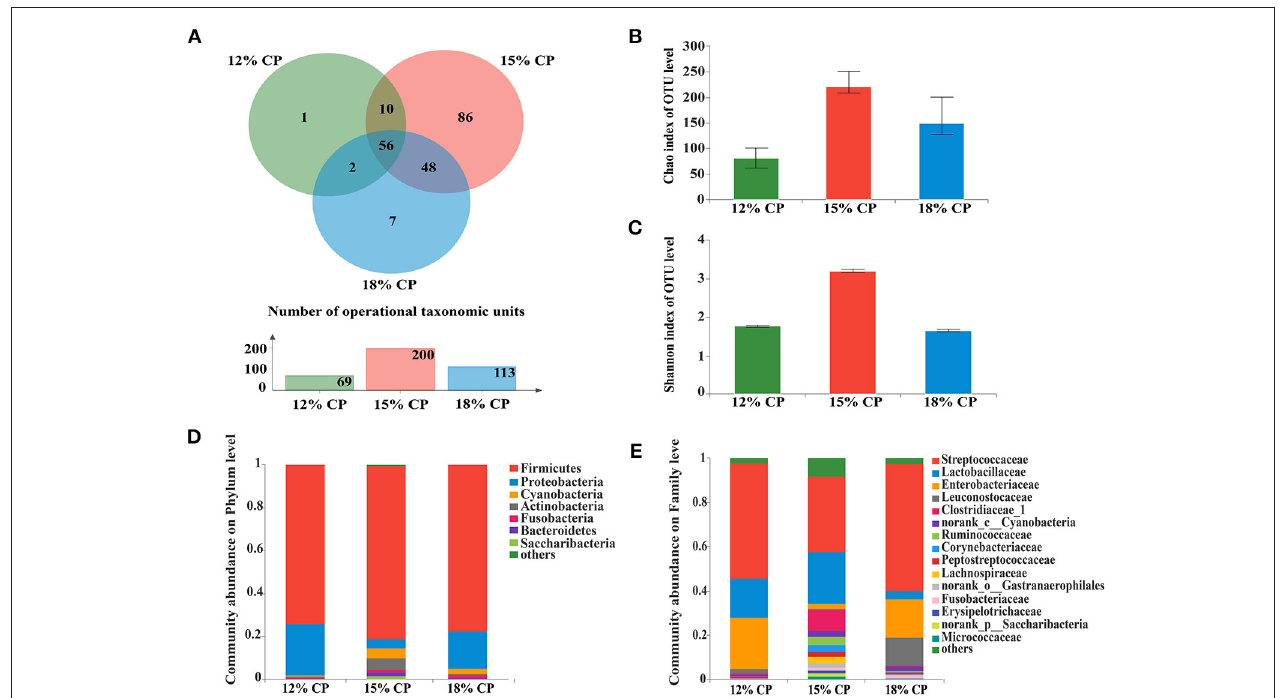
FIGURE 1 | Effects of low-protein diets on the richness and composition of ileal microbiota in growing pigs at the phylum and family levels. (A) Venn of the operational taxonomic units (OTUs) among different dietary treatments in the ileum. (B) Chao index of the bacterial community in the ileum. (C) Shannon index of the bacterial community in the ileum. (D) Distribution of ileal bacteria at the phylum level with relative abundance higher than 1%. (E) Distribution of ileal bacteria at the family level with relative abundance higher than 1%. group ( P < 0.05) and 3.74% in the 18% CP group ( P <